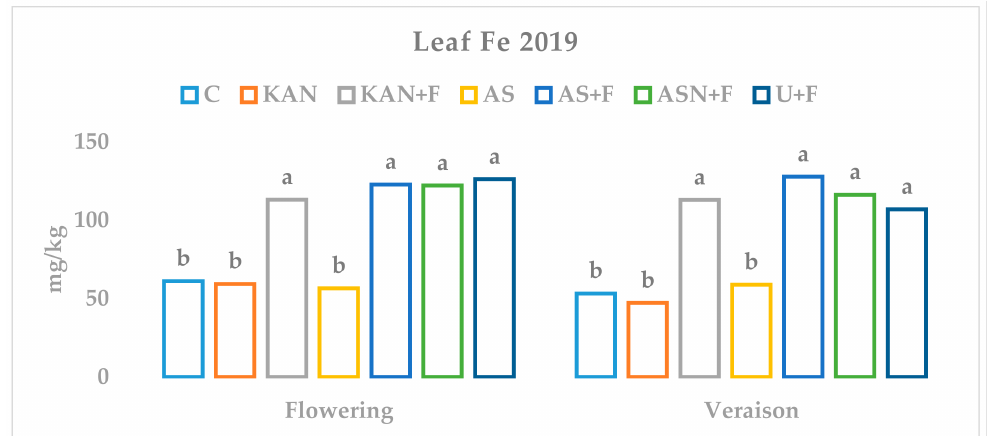
Figure 3. Influence of soil nitrogen fertilization and foliar fertilization on Fe grapevine leaves dynamic in 2019. Values marked with different letters refer to statistically significant differences ( p < 0.05) depending on